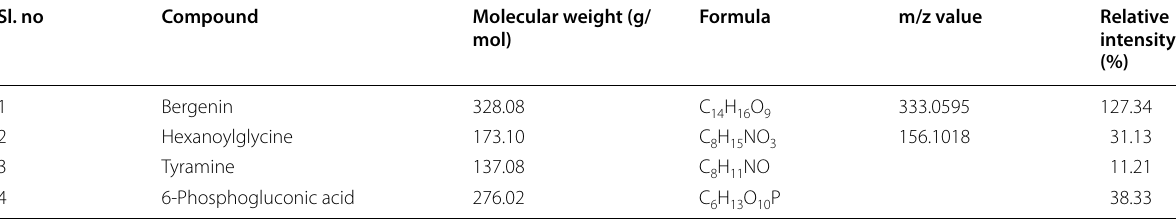
m/z mass-to-charge ratio